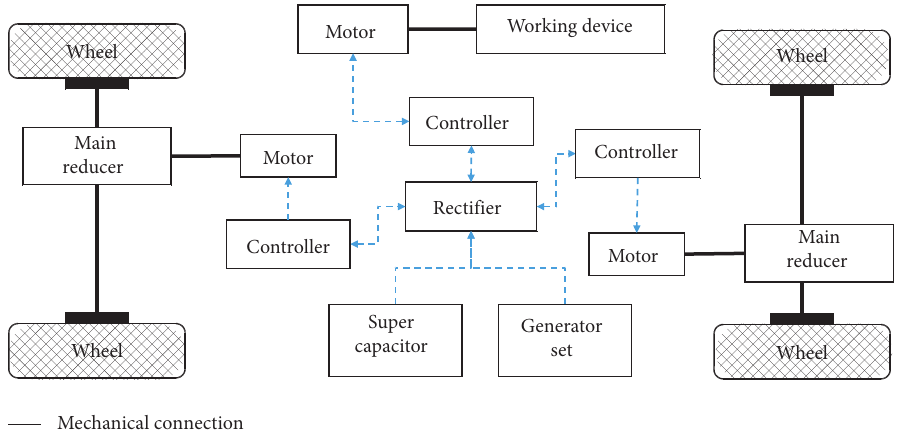
Figure 1: Structure principle of the FREWLs.